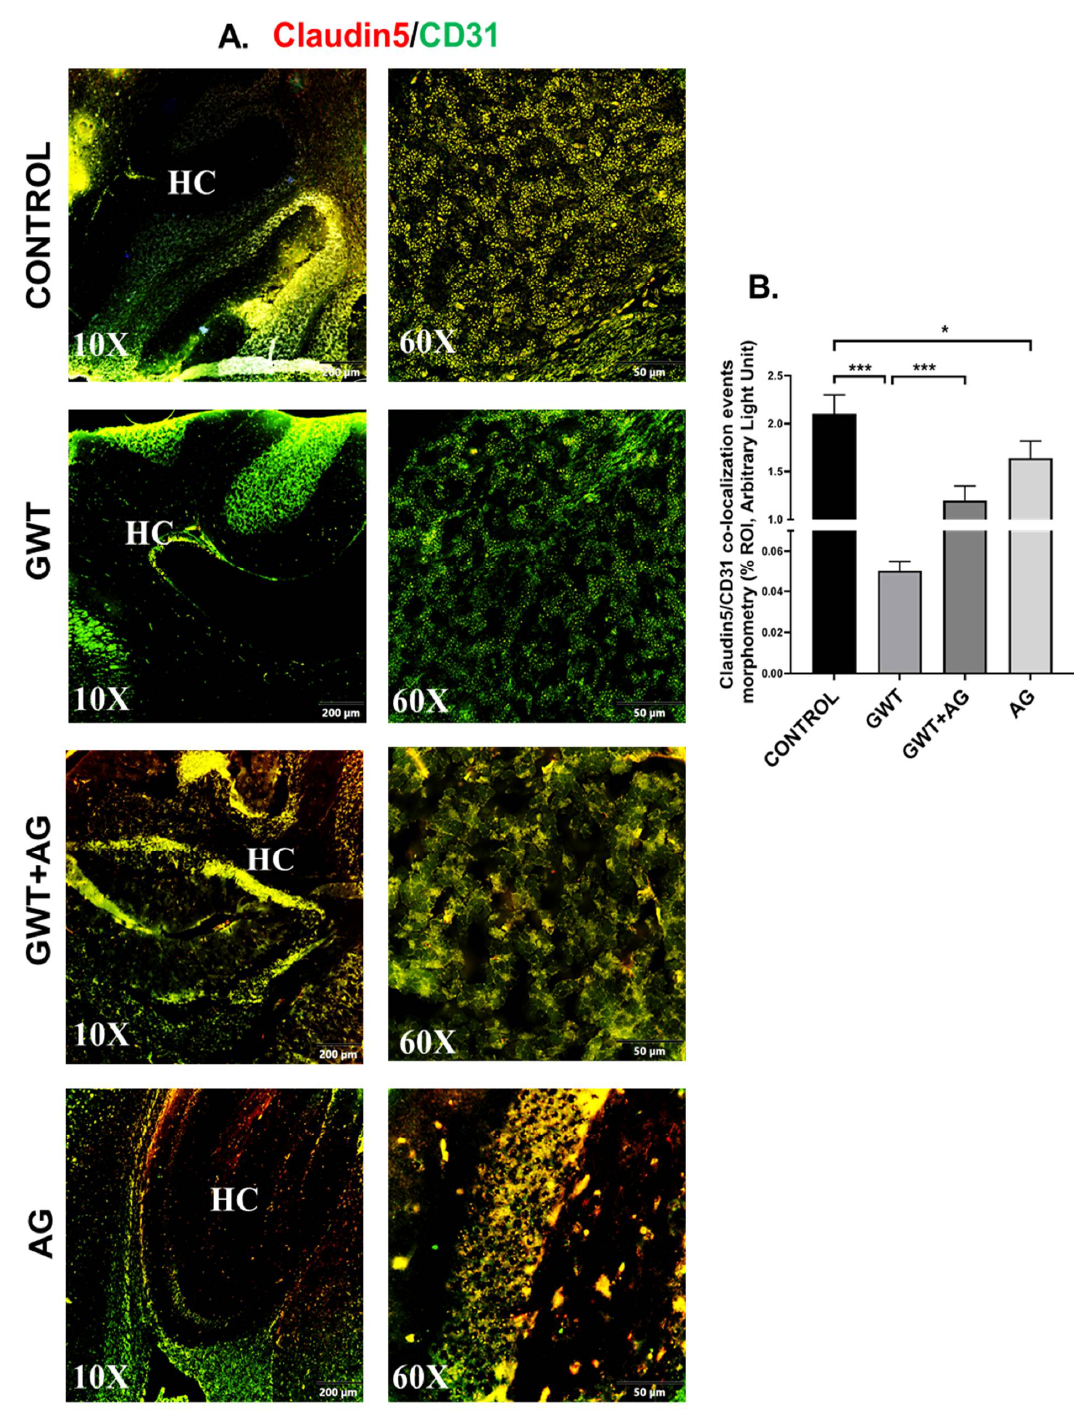
Figure 6. AG treatment improves GW chemical-induced Blood–Brain Barrier dysfunction. Representative immunofluo- rescence images depicting ( A ) Claudin-5 (red) and CD31 (green) co-localization events in the brain sections, counterstained with DAPI (blue) of CONTROL, GWT, GWT+AG, and AG mice groups. Images were taken at 10× and 60× magnification. Co-localization was represented by the yellow dots. The Hippocampus region is marked as HC. ( B ) Morphometric analysis (calculated as %ROI) of Claudin-5 and CD31 co-localization events. Y -axis represents % positive immunoreactive area (% ROI) ( n = 3; mean value taken from three separate microscopic fields) (* p < 0.05, *** p < 0.001). Data were represented as mean ± SEM and statistical significance was tested using unpaired t -test between the groups (* p < 0.05, ** p < 0.01, *** p < 0.001), followed by Bonferroni Dunn Post hoc